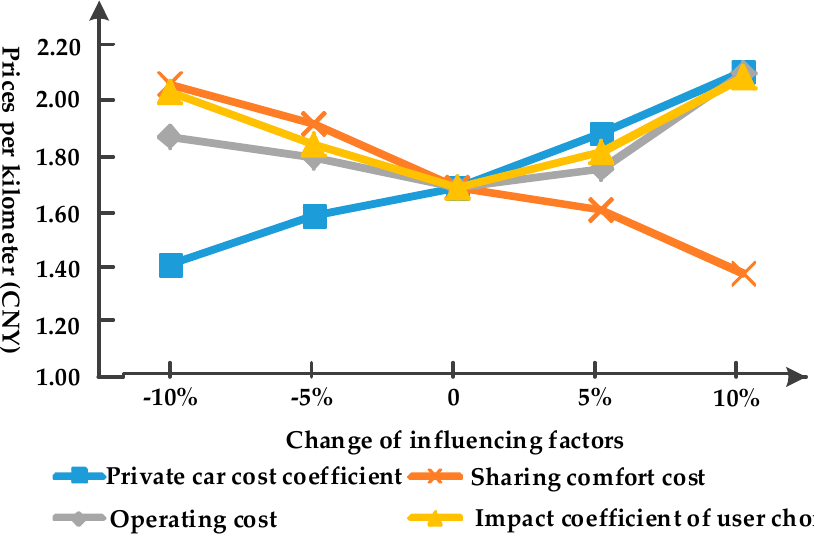
Appl. Sci. 2019 , 9 , x